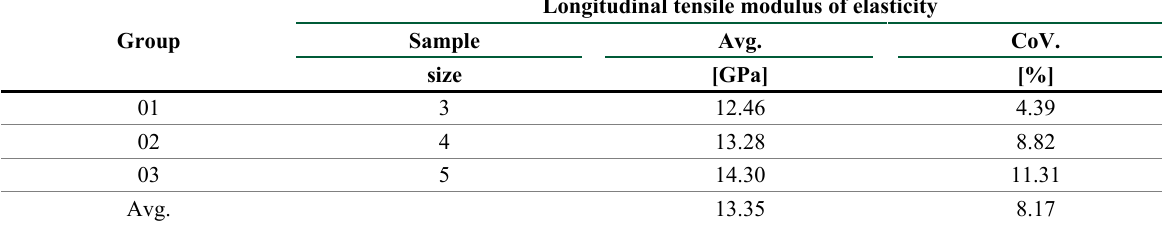
Table 3. Longitudinal tensile modulus of elasticity for GFRP plates Longitudinal tensile modulus of elasticity Sample Avg. CoV. Group size [GPa]